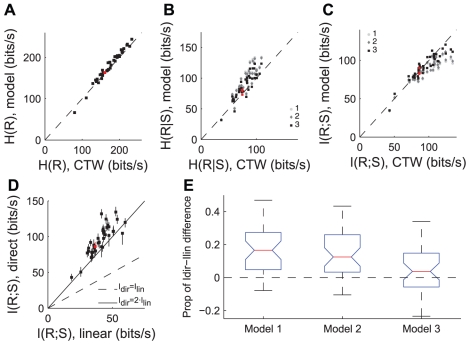
Comparison of information-theoretic quantities.A: Total response entropy rate for 40 neurons as measured using the context-tree-weighting (CTW) technique (x axis), vs. the modeled total response entropy (y axis). In panels A–D the red points indicate values from the cell in Figure 2, dashed black lines indicate unity between the x and y axes. B: Response entropy rate conditioned on a stimulus event as measured by CTW methods (x axis) vs models of the conditional entropy. C: Mutual information about the stimulus contained in the response patterns, calculated as the difference between total and conditional entropies of the response. X axis shows result of CTW estimation for each cell, y axis shows information calculation based on each of the three models. D: Comparison of mutual information measure using linear stimulus reconstruction approach (x axis) with estimation from CTW method. Solid black line indicates Idir = 2·Ilin E: Boxplot showing how much of the proportional difference of information between methodologies (Idir−Ilin) can be explained by varying temporal assumptions built in our models. For each of the three models, the boxplot shows the fraction of the information explained by the difference between that model and the direct method estimate from panel D, i.e. prop(x) = (Idir−Imodx)/(Idir−Ilin).